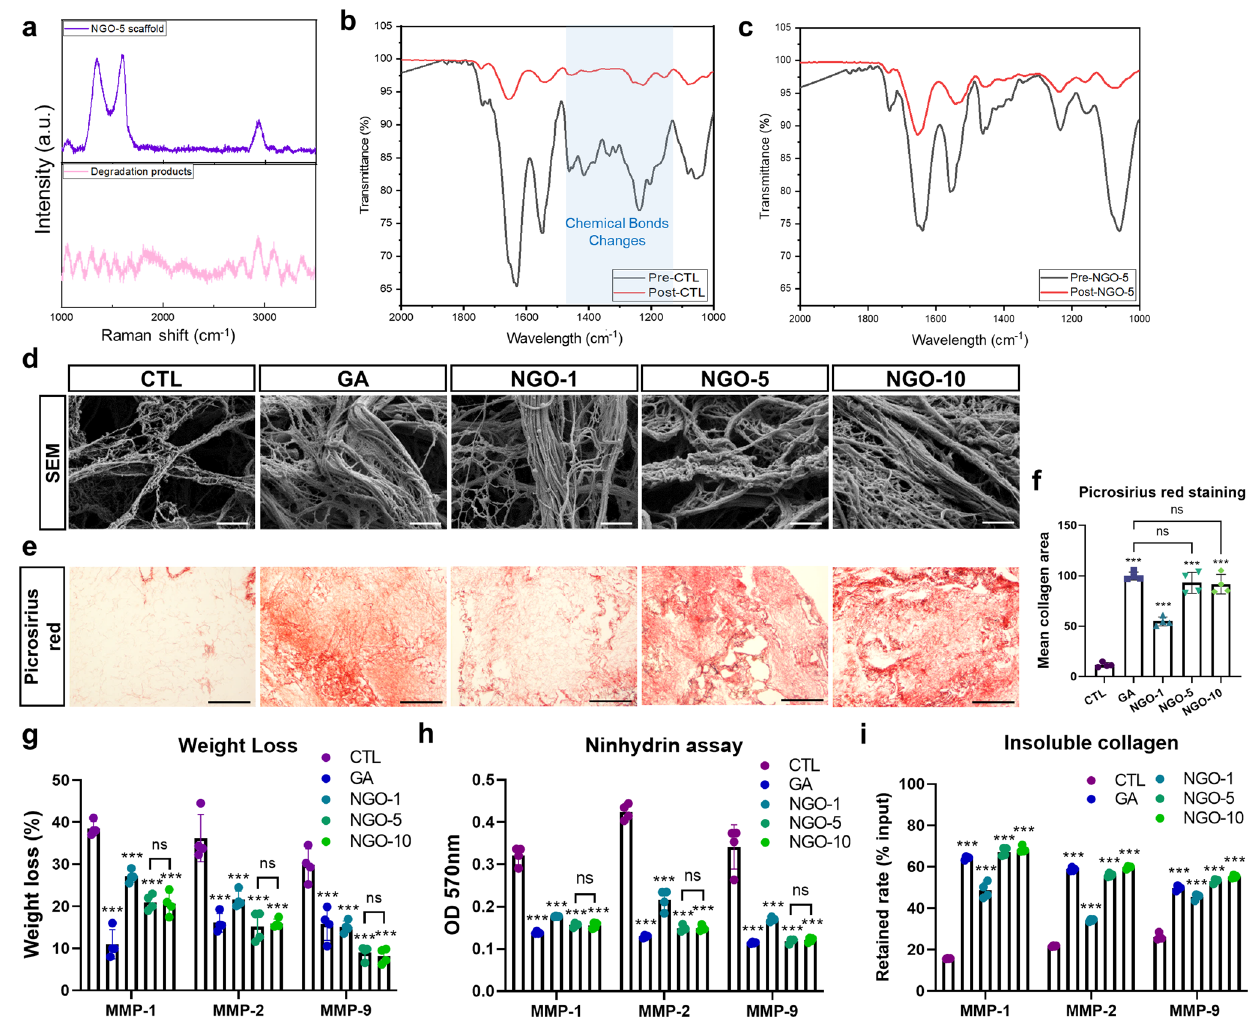
Fig. 2 | In vitro resistance of NGO-crosslinked scaffolds to enzymatic degra- dation.a Ramanspectraofscaffoldcrosslinkedwith5 μ g/mLnano-grapheneoxide (NGO-5) after MMP-1 treatment (top) and degradation products of MMP-treated scaffold (bottom). b,c Fourier transform infrared spectroscopy (FTIR) spectra of non-crosslinkedscaffolds(CTL)andNGO-5scaffoldsweremeasuredbefore(black) and after(red) MMP-1 treatment. d Scanning electron microscopy(SEM) images of thecrosslinkedscaffoldsafterMMP-1treatmentfor2h.Scalebar,1 µ m. e Picrosirius red staining of the scaffolds degraded by MMP-1. Scale bar, 200 µ m. f Area quan- ti fi cation of collagen fi bers stained by picrosirius red ( n =4). g Weight loss